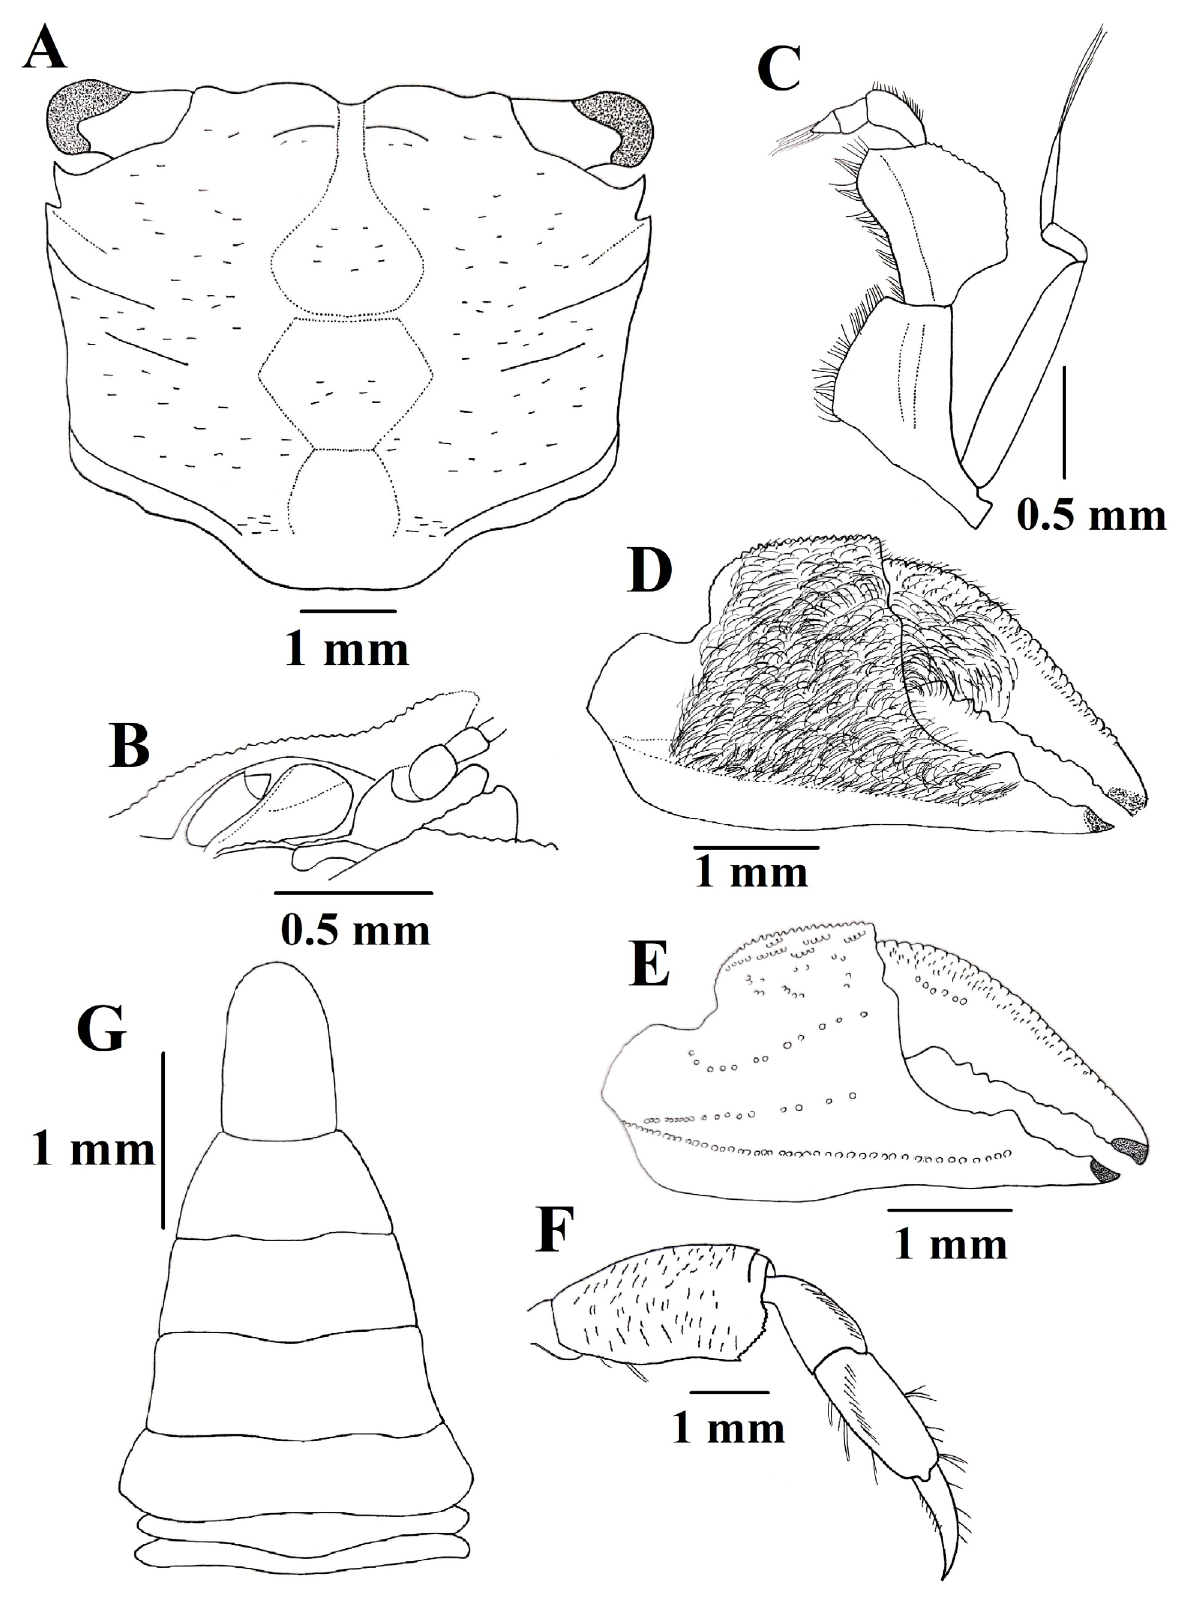
Figure 5. Nanosesarma sarii Naderloo and Türkay, 2009, male (LFSC.ZRC-188) (CL: 5.6 mm; CW: 6.6 mm), Shivrajpur, Gujarat, India. ( A ) Carapace; ( B ) basal antennular and antennal articles; ( C ) left third maxilliped; ( D ) palm of right cheliped (with setae); ( E ) palm of right cheliped (outer face without setae); ( F ) right P5 (dorsal view); ( G ) male